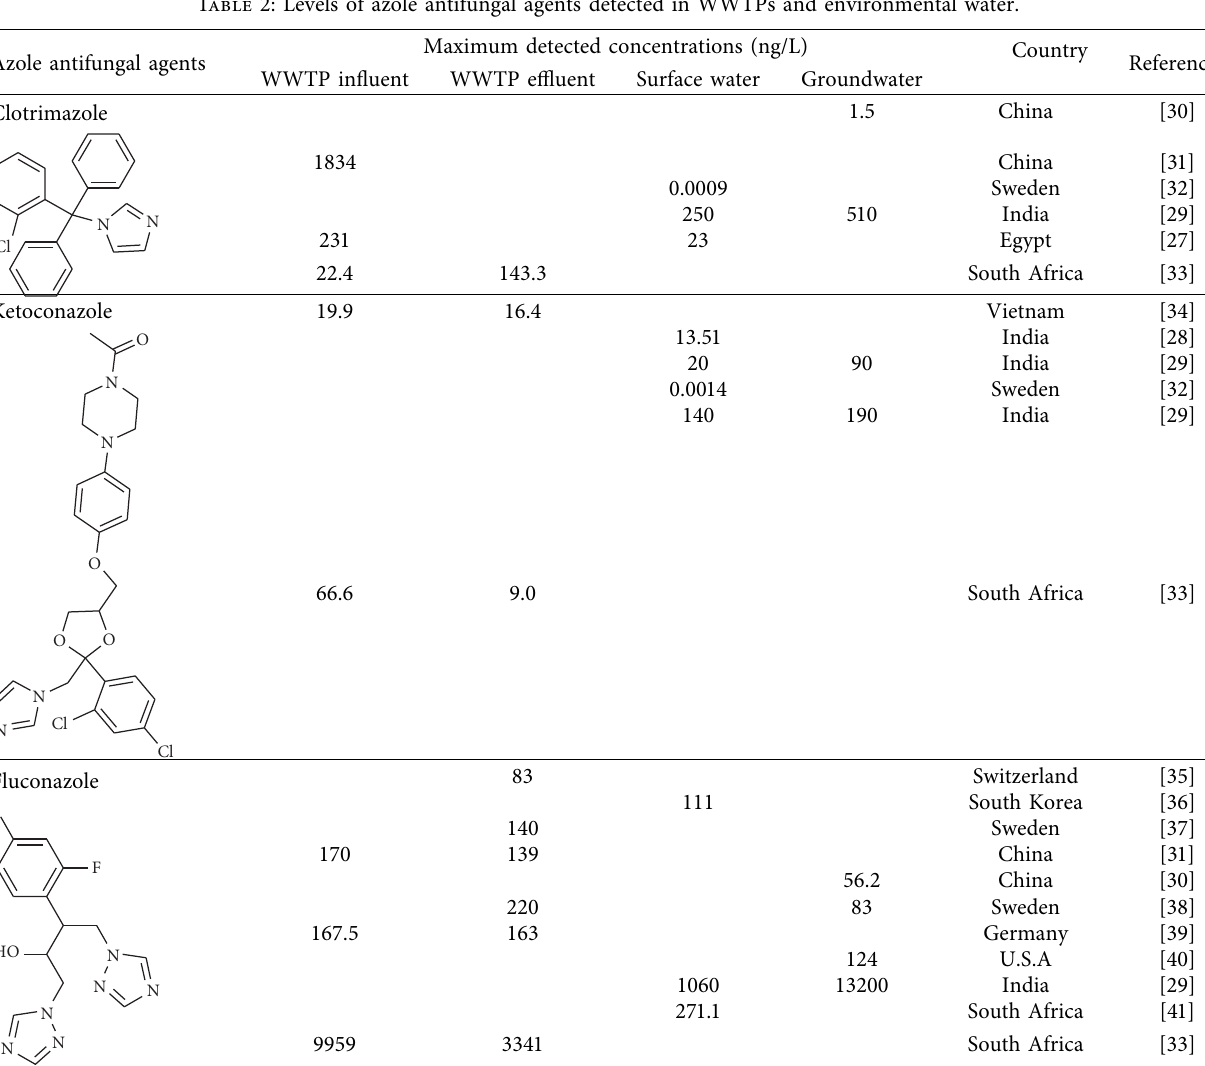
Table 2: Levels of azole antifungal agents detected in WWTPs and environmental